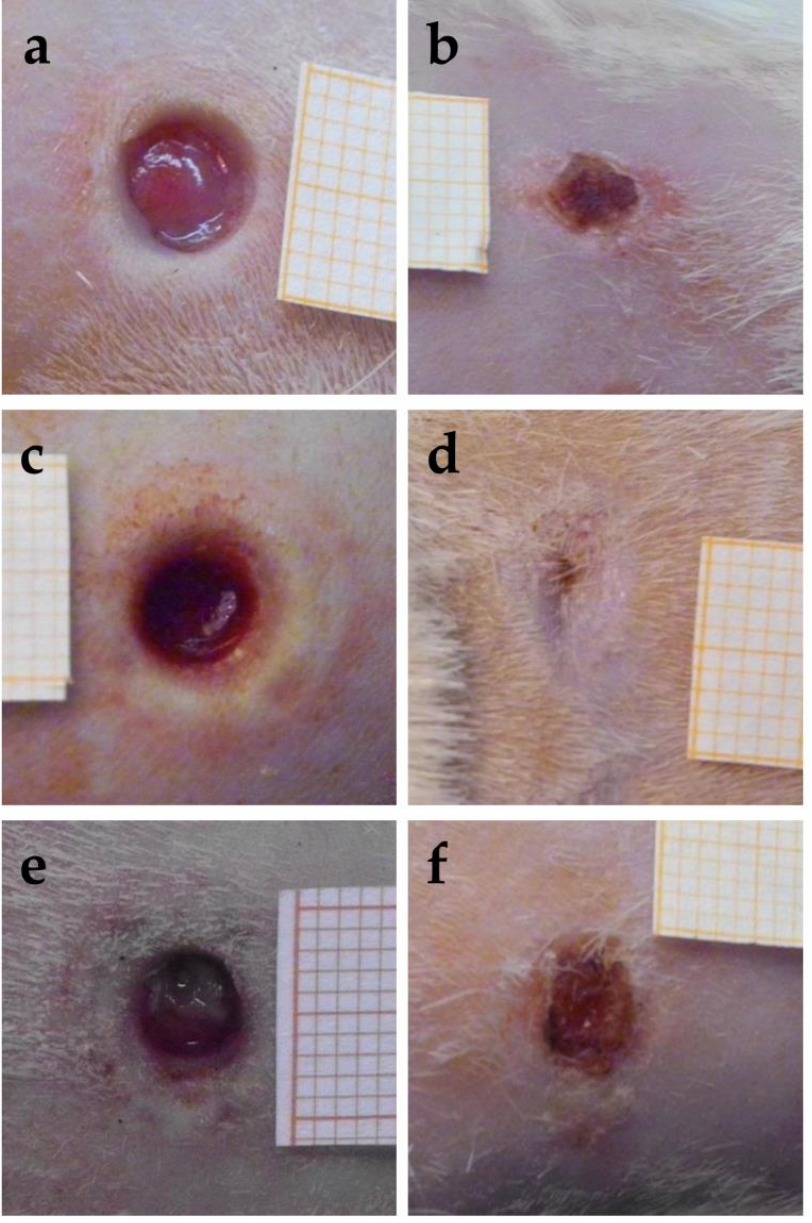
Figure 11. Representative images of third-grade excisional wounds 24 h after thermic injury ( a , c , e ) and after 18 days of treatment with CSO–CO 50 ( b ), CSO–CO 100 ( d ), or saline solution (NaCl, 0.9% w / v ) as a reference ( f ). One square of the reference grid corresponds to 1 mm 2 .